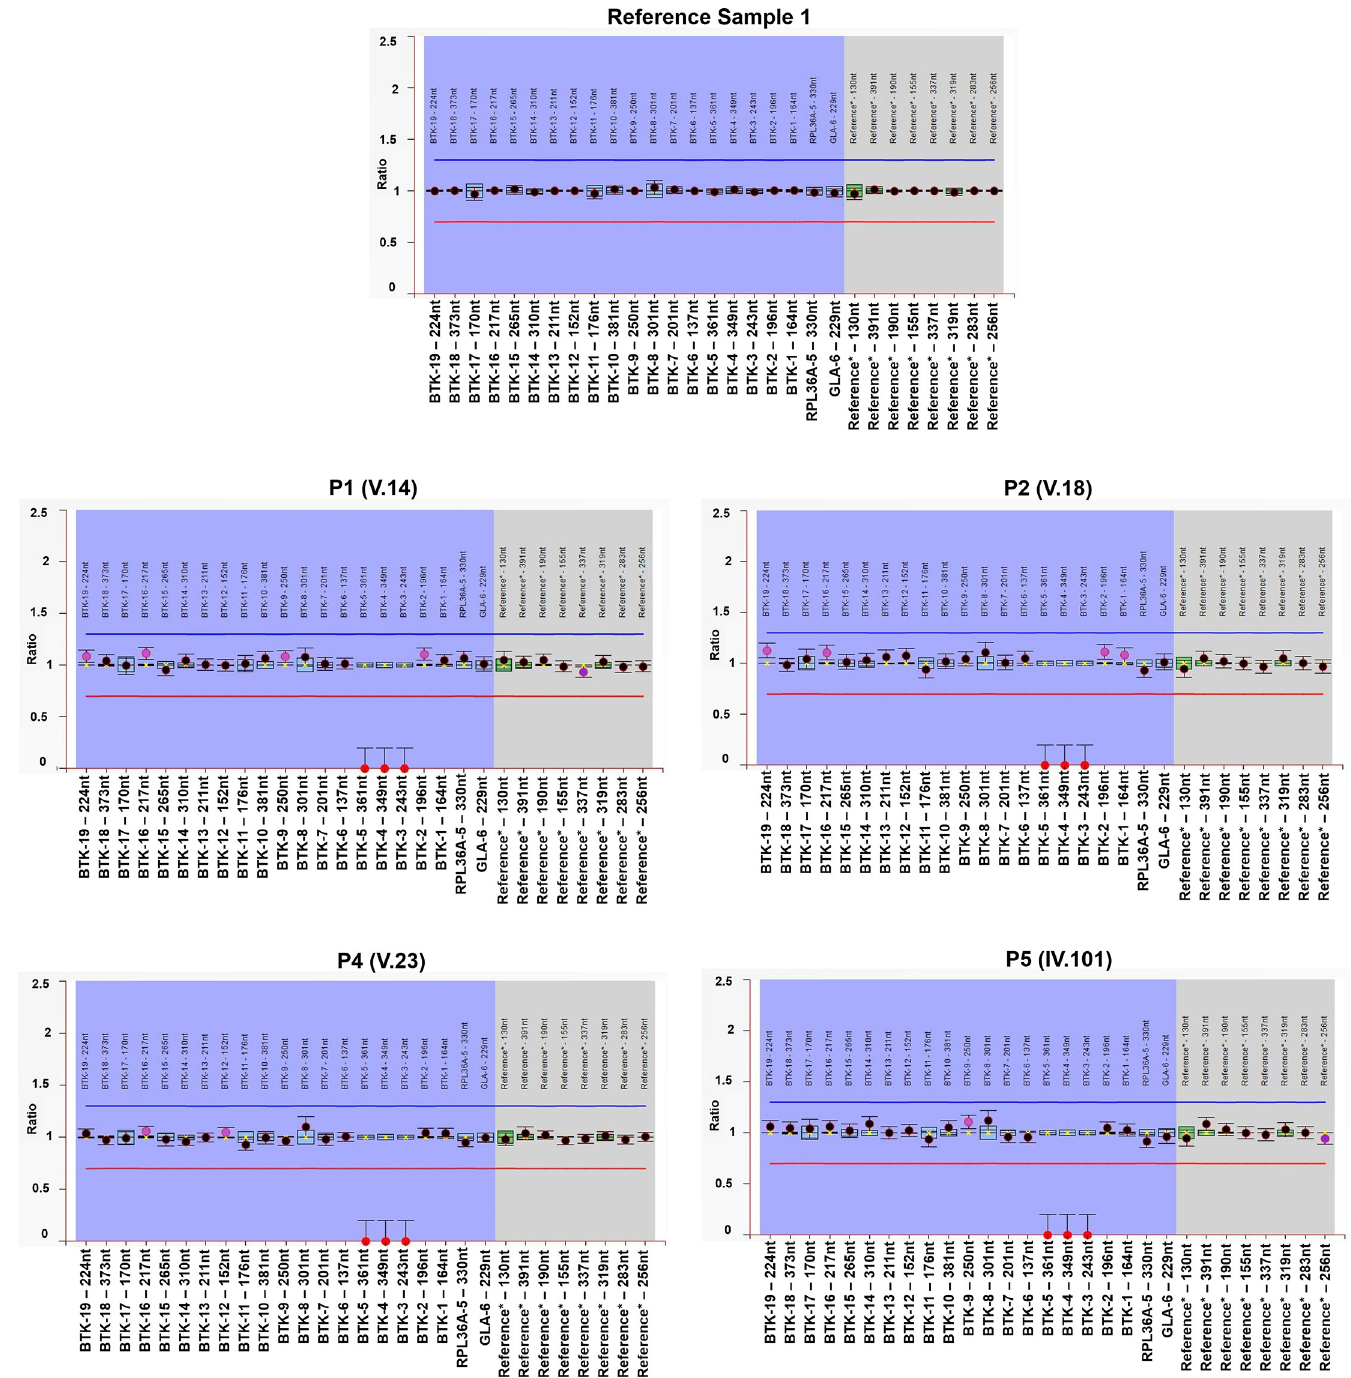
Fig 3. Multiplex ligation dependent amplification (MLPA) assay for detection of deletion encompassing 3–5 exons of the BTK gene: Representation of ratio charts generated using the Coffalyser.net software. (A) Reference sample depicts the normal copies of the BTK gene and other samples (B) Sample P1 (C) Sample P2 (D) Sample P4 (E) Sample P5 are all males and depict probe ratio of zero for 3–5 exons of the BTK gene which lies on X-chromosome, i.e. they have hemizygous deletion. For all the ratio charts, the longitudinal axis (X-axis) represents the final ratios after inter and intra normalisations of the probe ratios. Horizontal axis (Y-axis) represents the probe names alongwith the length in the order (Both axis title have been manually enlarged for clarity). The blue and red horizontal lines depict the arbitrary borders of ratio 1.3 and 0.7 respectively. The black and red dots denote the final ratio obtained for each of the probes and the vertical bars represent the 95% confidence range for each probe. The Roman and numeric numbers on top of each ratio chart represent the individual marked as per the pedigree in Fig 1.